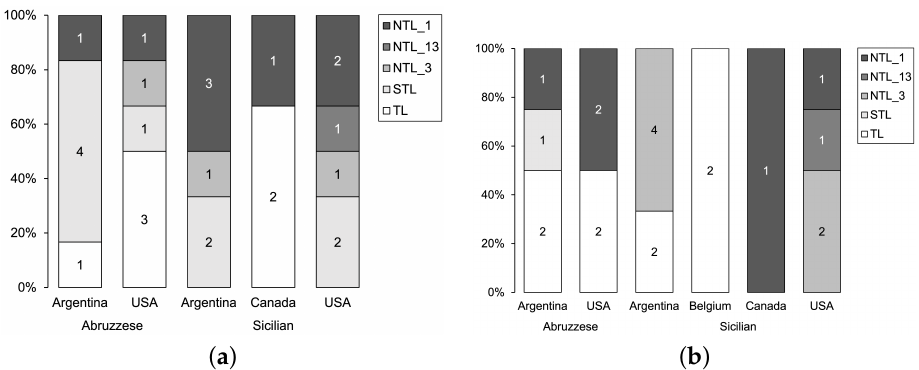
Figure 5. Hearer-related deictic domain across heritage varieties considered in different contact contexts: results for picture sentence matching task ( a ) and semi-guided production ( b ).